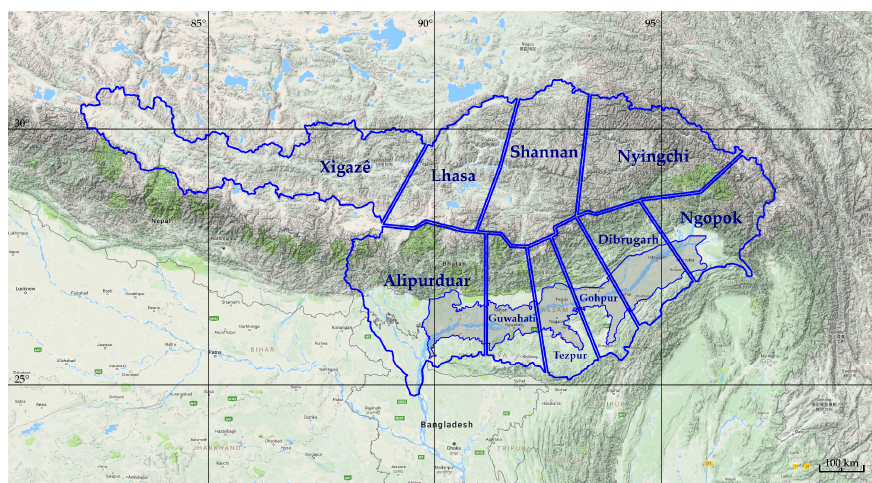
Figure 4. The distinguished regions of the Brahmaputra river basin.